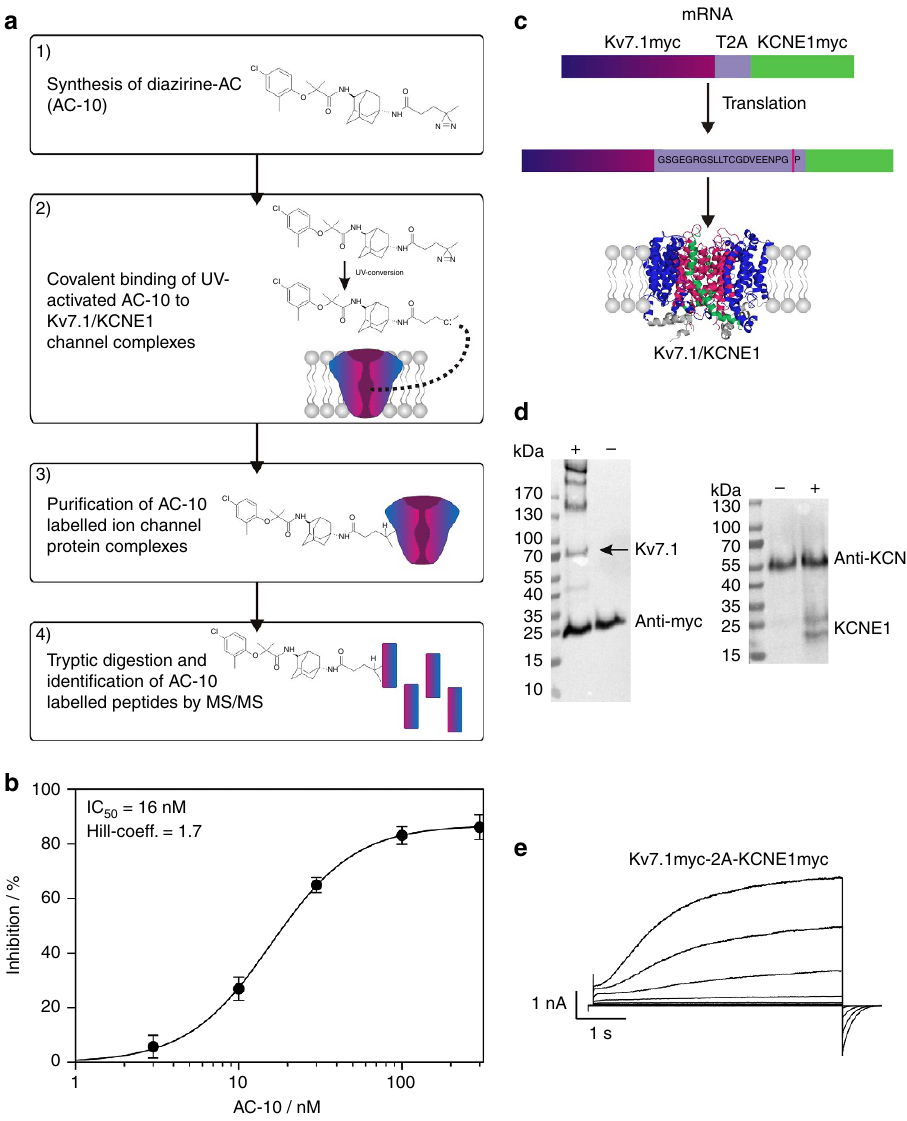
Figure 5 | PAL-based approach to identify AC binding site. ( a ) Schematic view of the PAL-based approach to investigate the binding site of AC-1. ( b ) Concentration-response curve for AC-10, the UV-active diazirine derivate of AC-1. The inhibitory effect of AC-10 was determined in CHO cells stably expressing Kv7.1/KCNE1. Inhibition was determined as percent change in current amplitude at the end of the depolarizing test pulse to þ 40mV ( ± s.e.m.). ( c ) A new cDNA-construct (Kv7.1myc-2A-KCNE1myc in pXOOM ) allows for functional expression of myc-tagged Kv7.1 and KCNE1 in HEK293Tcells. In this construct, cDNAs of Kv7.1 and KCNE1 are linked via the T2A peptide sequence, which mediates co-translational protein cleavage 42 . ( d ) Western blot analysis of affinity purified Kv7.1 and KCNE1 proteins. Kv7.1myc was purified using myc-agarose beads KCNE1 was purified using anti-KCNE1 coupled protein-A-sepharose beads (right). In both western blots, ‘ þ ’ indicates transfected cells, ‘ (cid:2) ’ indicates non-transfected control cells. Antibodies used for affinity purification are detected in ‘ þ ’ and ‘ (cid:2) ’. Additional protein bands proved the expression of Kv7.1 and KCNE1 proteins. It should be noted, that KCNE1, as a myc-tagged protein, should also be purified using the myc-agarose beads. Since the respective KCNE1 band is of comparable size to the anti-myc band, it is not possible to distinguish between them. Thus, KCNE1 expression was instead proven using the KCNE1 antibody. ( e ) Functional expression of Kv7.1myc-2A-KCNE1myc in HEK293T cells (scale bars indicate 1nA,